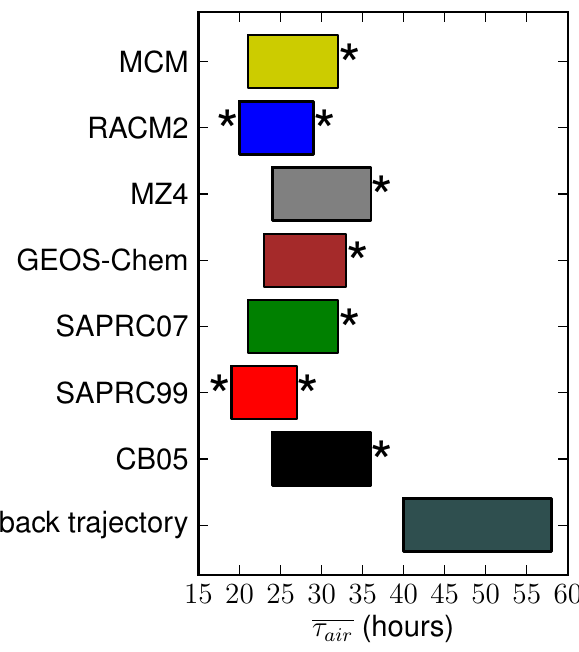
Fig. 3. Range of estimated mean air parcel lifetimes ( τ air ) derived from back trajectory and chemical simulation. Asterisks indicate whether chemically simulated NO x :HNO 3 is statistically consis- tent with observations ( α < 0 . 01) when using the exponential (left, Eq. 3) and bias-corrected (right, Eq. 4) statistical